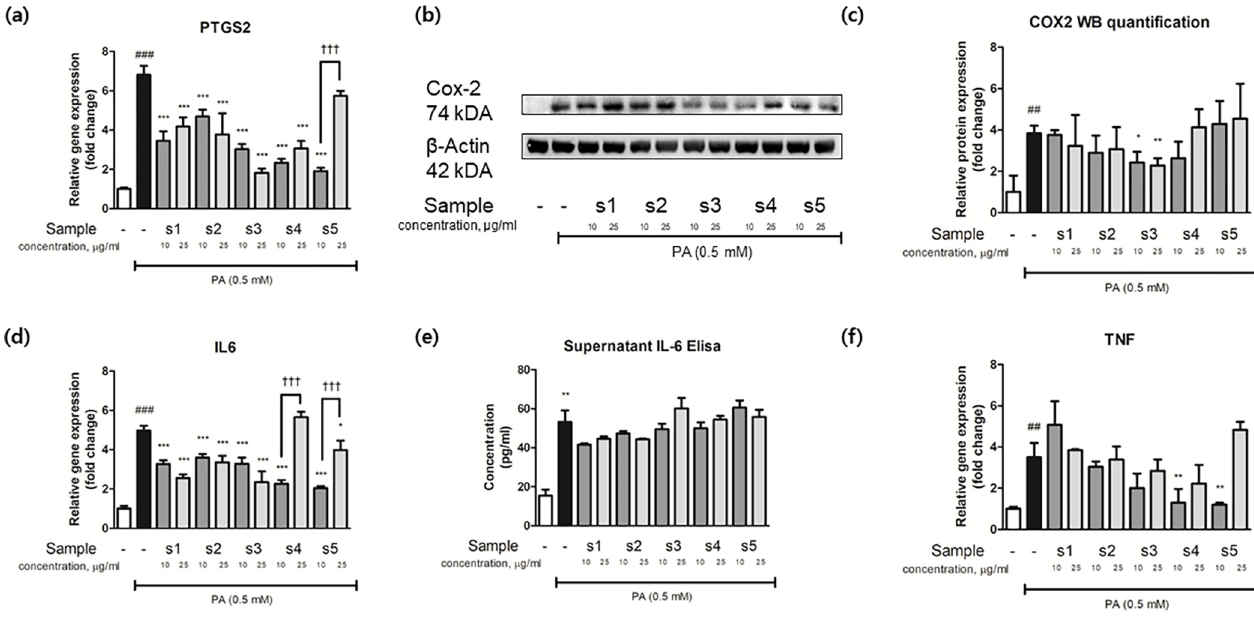
Fig 10. Relative protein levels and gene expression levels of inflammatory markers, predicted by network pharmacology analysis, were subjected to western blot and real-time quantitative PCR in palmitate-treated (0.5 mM) preadipocytes. Real-time quantitative PCR results for (a) PTGS2, (d) IL6, and (f) TNF. (b) Representative blots of PTGS2 and β -actin. (c) Band intensities were measured densitometrically and divided by that of β -actin. Relative gene expressions were calculated by dividing Ct values by that of β -actin. Results are presented as the means ± SDs of three different experiments. ##P < 0.01, and ###P < 0.001 versus non-treated 3T3-L1 preadipocytes, and � P < 0.05, �� P < 0.01, and ��� P < 0.001 versus non-treated adipocytes.